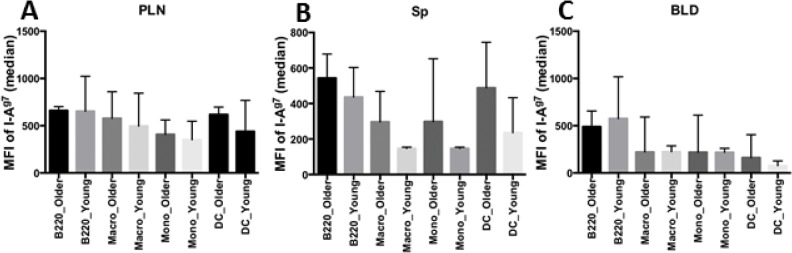
Similar I-Ag7 level of various antigen presenting cell (APC) types from young resistants and older progressors.MFI of I-Ag7 from PLN (A), spleen (B) and blood (C) was summarized and analyzed by unpaired 2-tailed T test. B220 was used as a marker for B cells. Macro, Mono, and DC stand for macrophages, monocytes and dendritic cells respectively. No significant difference between young resistants and older progressors was found.